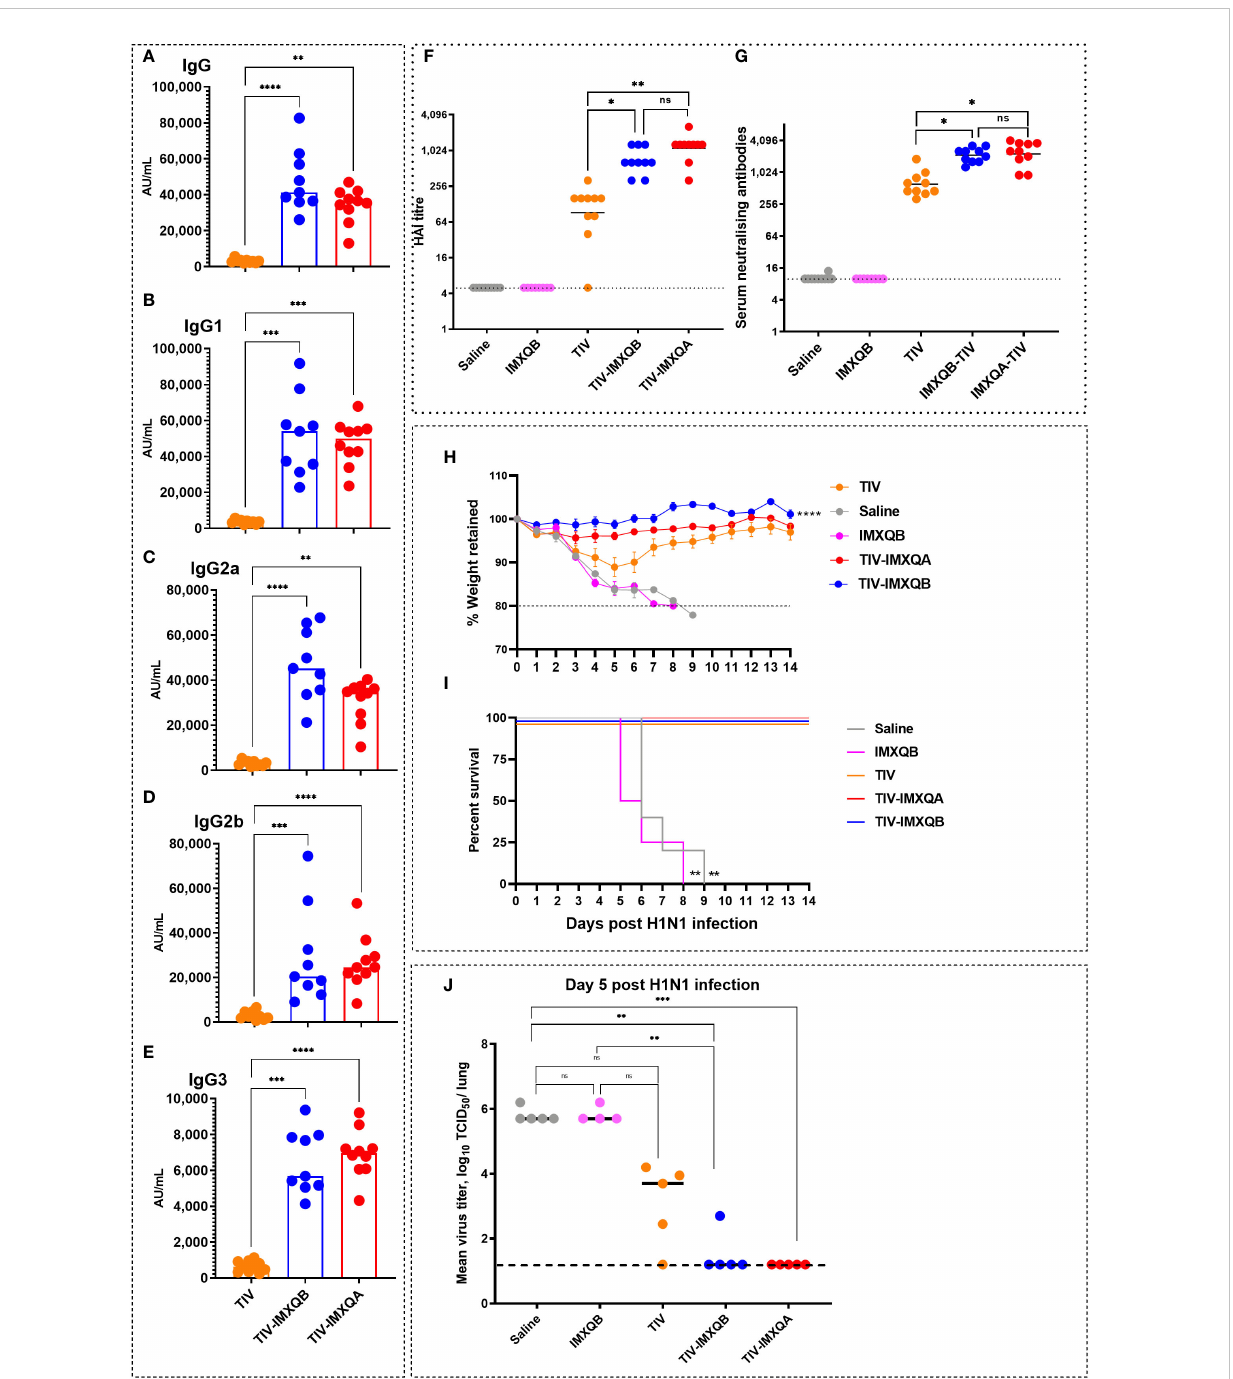
FIGURE 3 Subcutaneous (s.c.) injections of TIV-IMXQB-adjuvanted trivalent in fl uenza vaccine (TIV) elicited higher antibody levels than commercial TIV alone and conferred nearly complete protection upon challenge. Female BALB/c mice were vaccinated by the s.c. route on days 0 (priming) and 14 (booster) with either TIV-IMXQB, the TIV-IMXQA-adjuvanted formulation, or TIV alone (commercial vaccine). Total anti-TIV IgG (A) , IgG1 (B) , IgG2b (C) , IgG2a (D) , and IgG3 (E) were determined 2 weeks after the second immunization (day 28). The median value is indicated by a line, and the dots indicate individual values. Anti-in fl uenza virus antibody titers in serum samples were measured by hemagglutination inhibition (HAI) (F) or microneutralization (MN) (G) assays. The geometric mean value is indicated by a line, and the dots indicate individual values. Thirty days after priming, all animals in each group ( n = 10 per group) were intranasally challenged with 1 × 10 6 TCID (median tissue culture infectious dose)/50 µL of A/Uruguay/897/2018 (H1N1)pdm09 in fl uenza virus. Five animals per group were monitored for weight loss (H) (represented by mean and error) and mortality (I) . The remaining fi ve mice per group were used to determine viral titers in the lungs on day 5 post challenge (J) . The median value is indicated by a line, and the dots indicate individual values. Percentage survival compared with trivalent in fl uenza vaccine (TIV) alone (unadjuvanted TIV antigen) was determined by a log-rank (Mantel – Cox) test. Statistical analyses were performed using the non-parametric Kruskal – Wallis test with uncorrected Dunn ’ s post hoc test for multiple comparisons or a log-rank (Mantel-Cox) test, and each group was compared with the TIV mock group. In (A-G, J) , median values are indicated by horizontal lines and dots indicate individual values for each animal. The dotted horizontal line in Figure (J) represents the lower limit of detection. Signi fi cant differences are indicated: * p < 0.05, ** p < 0.01, *** p< 0.001, and **** p< 0.0001. ns, non-signi fi